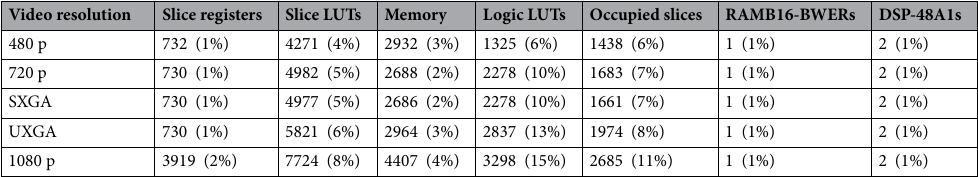
Table 2. Summary of results for different video